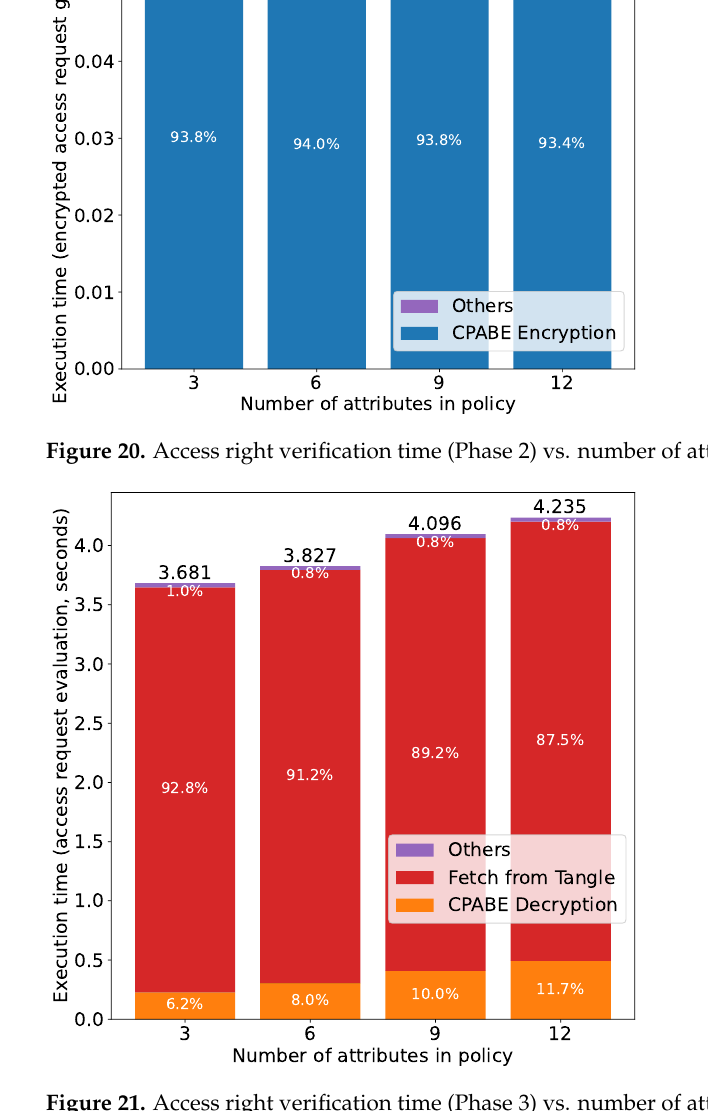
Figure 21. Access right verification time (Phase 3) vs. number of